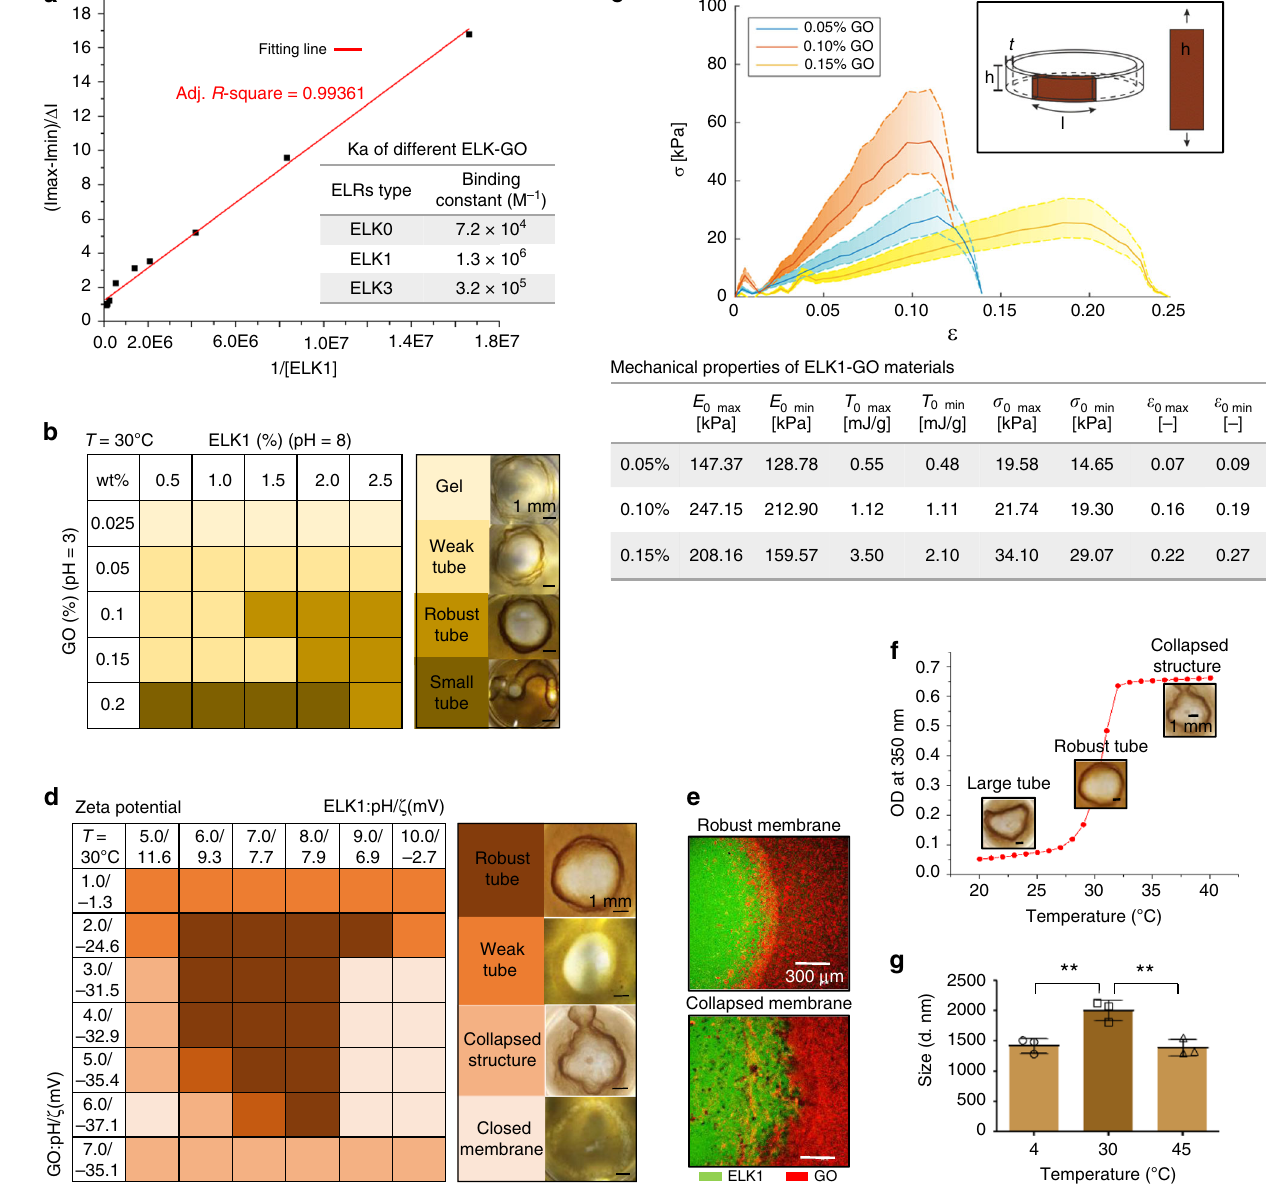
Fig. 3 Molecular interaction, composition, and mechanical properties of ELR – GO. a Binding constants (Ka) for the different ELR-GO combinations calculated by a Benesi – Hildebrand equation based on fl uorescence emission titration of a mixture of GO (2.5 × 10 − 3 wt%) in MilliQ water solution and increasing concentrations of ELRs revealing higher Ka for ELK1 – GO compared to ELK0 – GO and ELK3 – GO. b Table illustrating the role of building-block concentration ratio on the formation of ELK1 – GO tubes. c Nanotensile test results described with the Weibull distribution and reported in the table reveal that the strength, the strain at break, and the toughness modulus increased on tubes formed with increasing concentrations of GO but the elastic modulus was highest on tubes made with medium level (0.10%) GO compared to lower (0.05%) and higher (0.15%) amounts. d Table illustrating the role of pH and ζ on the formation of the ELK1 – GO tubes and their respective geometry. e Representative confocal microscopy qualitatively depicting the interface between ELK1 (green) and GO (red) during tube formation with different levels of de fi nition as characterized in d . f Red line of the graph shows the turbidity changes of an ELK1 (2 wt%) solution in MilliQ water while inserted images depict the de fi nition of tubes formed at speci fi c temperatures. g Dynamic light scattering (DLS) revealing the presence of larger ELK1 – GO aggregates at 30 °C compared to 4 °C and 45 °C. Error bars represent ±s.d. for n = 3. * p < 0.05. One-way